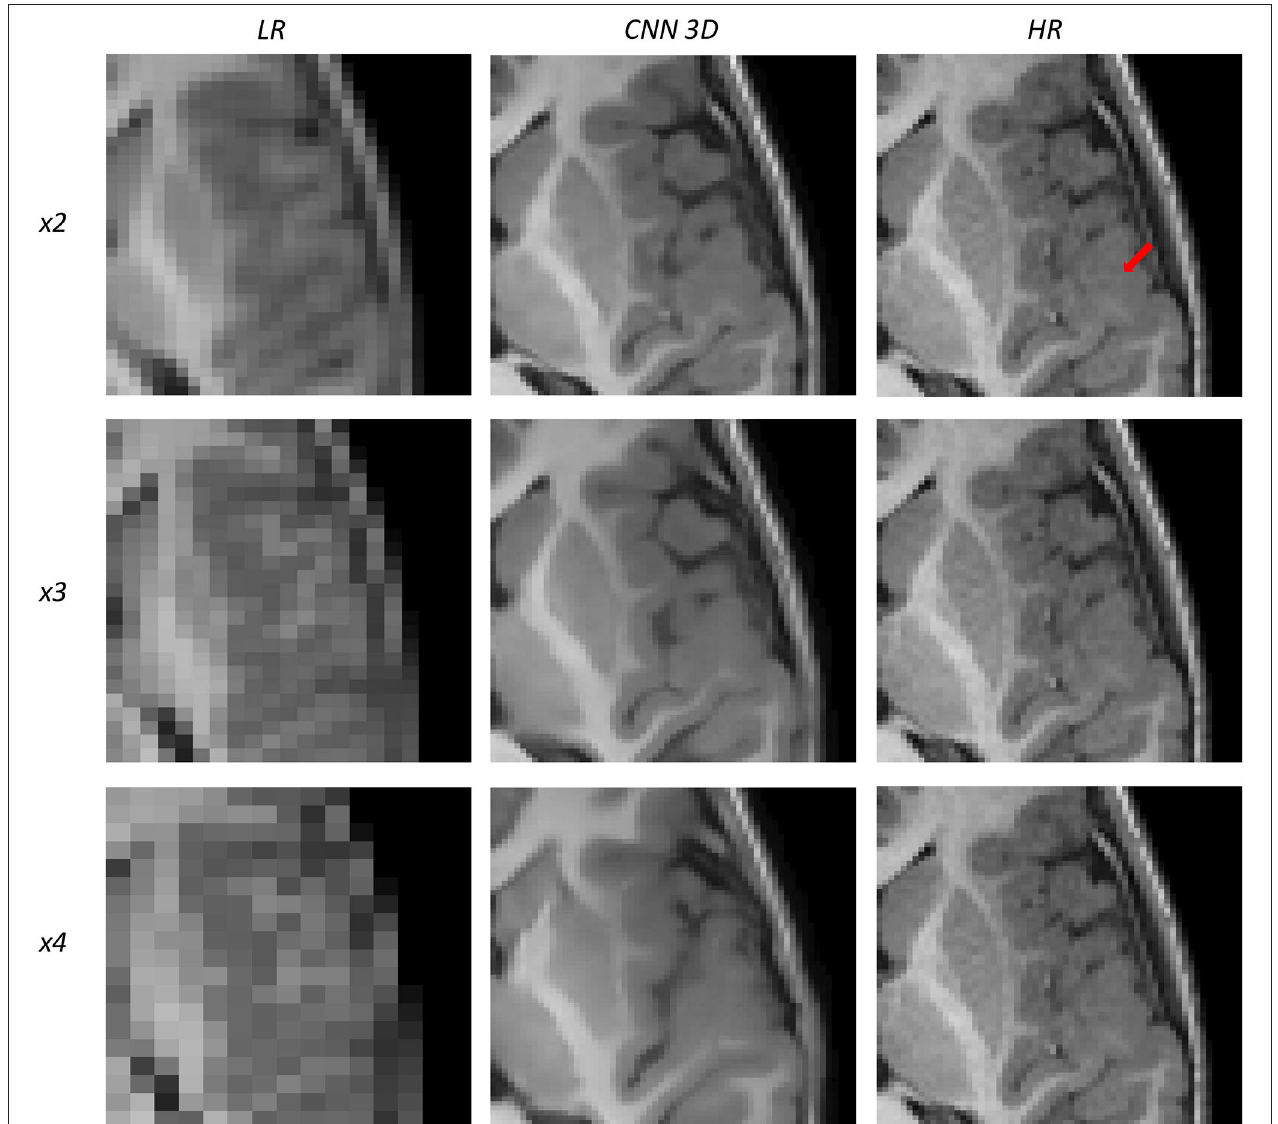
FIGURE 12 | Results of both CNN methods on three scaling factors of super-resolution on images of a patient with dysplasia. A specific region of a slice is shown, with the red arrow pointing to a lesion.